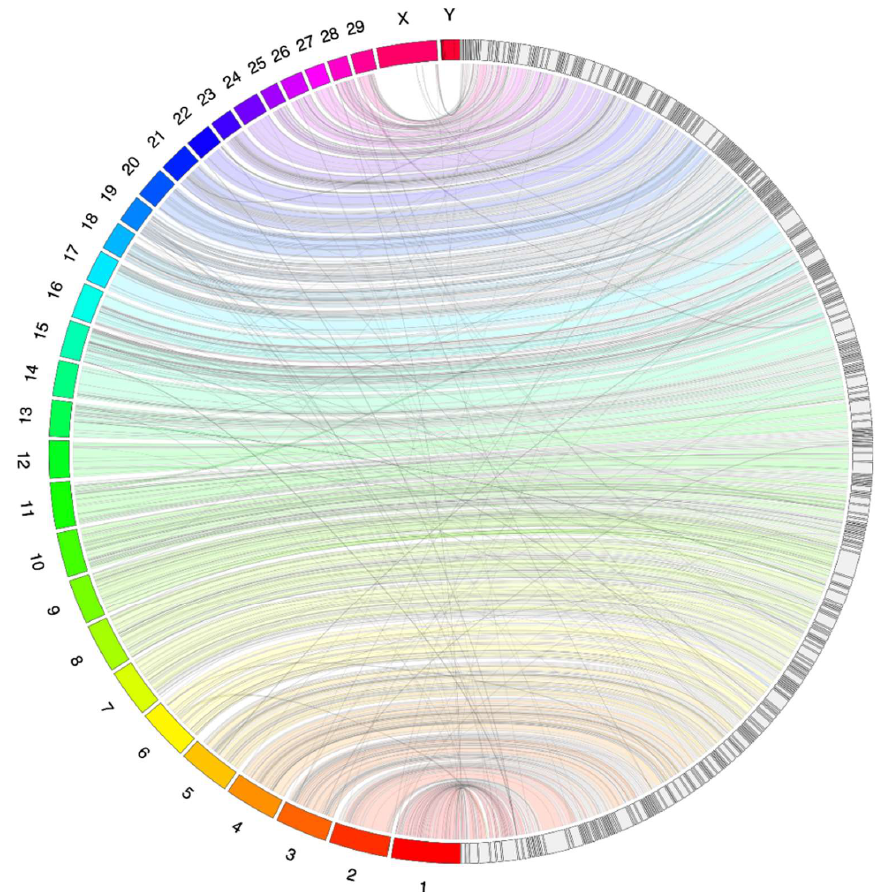
Figure 1. A Jupiter plot showing an alignment between the bovine chromosomes and the caribou genome assembly. The left of the circle shows the numbered bovine chromosomes, and the right of the circle has the largest 312 scaffolds from our assembly, which cover 75% of the bovine genome. Coloured bands represent synteny between the genomes, and lines crossing the circle indicate genomic rearrangements, or break points in the scaffolds.